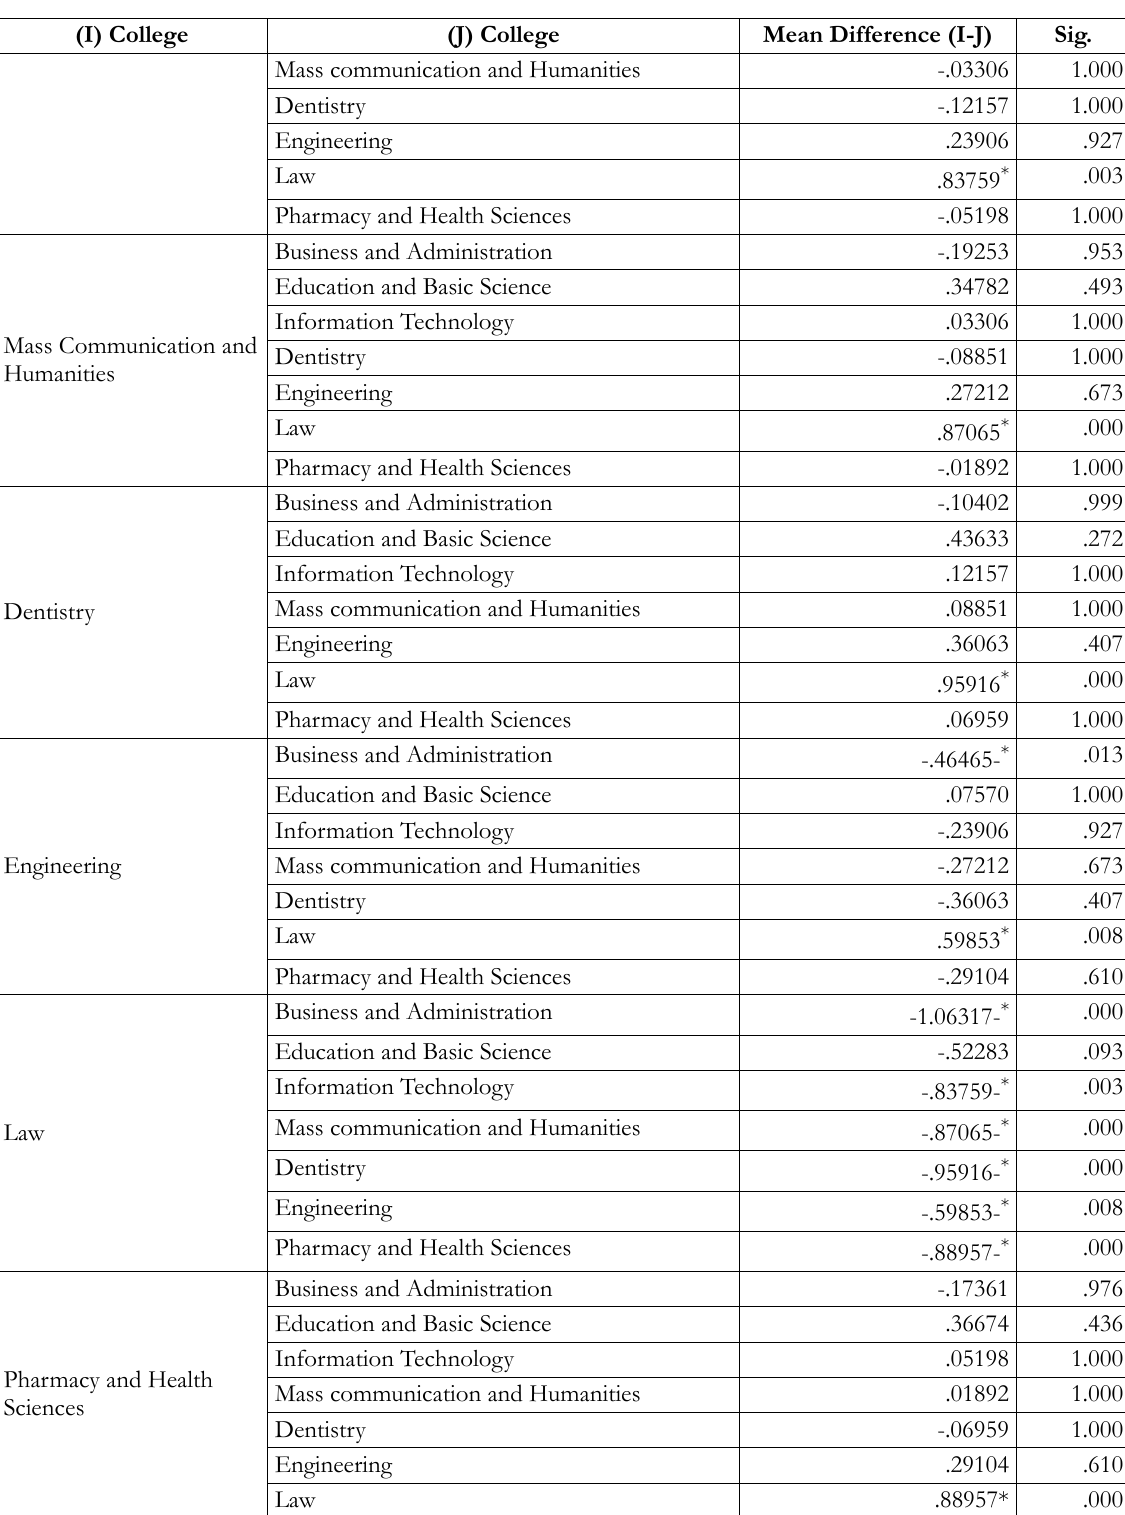
Table 10. Schiffe test results to identify the source of differences of the students’ responses, according to the college